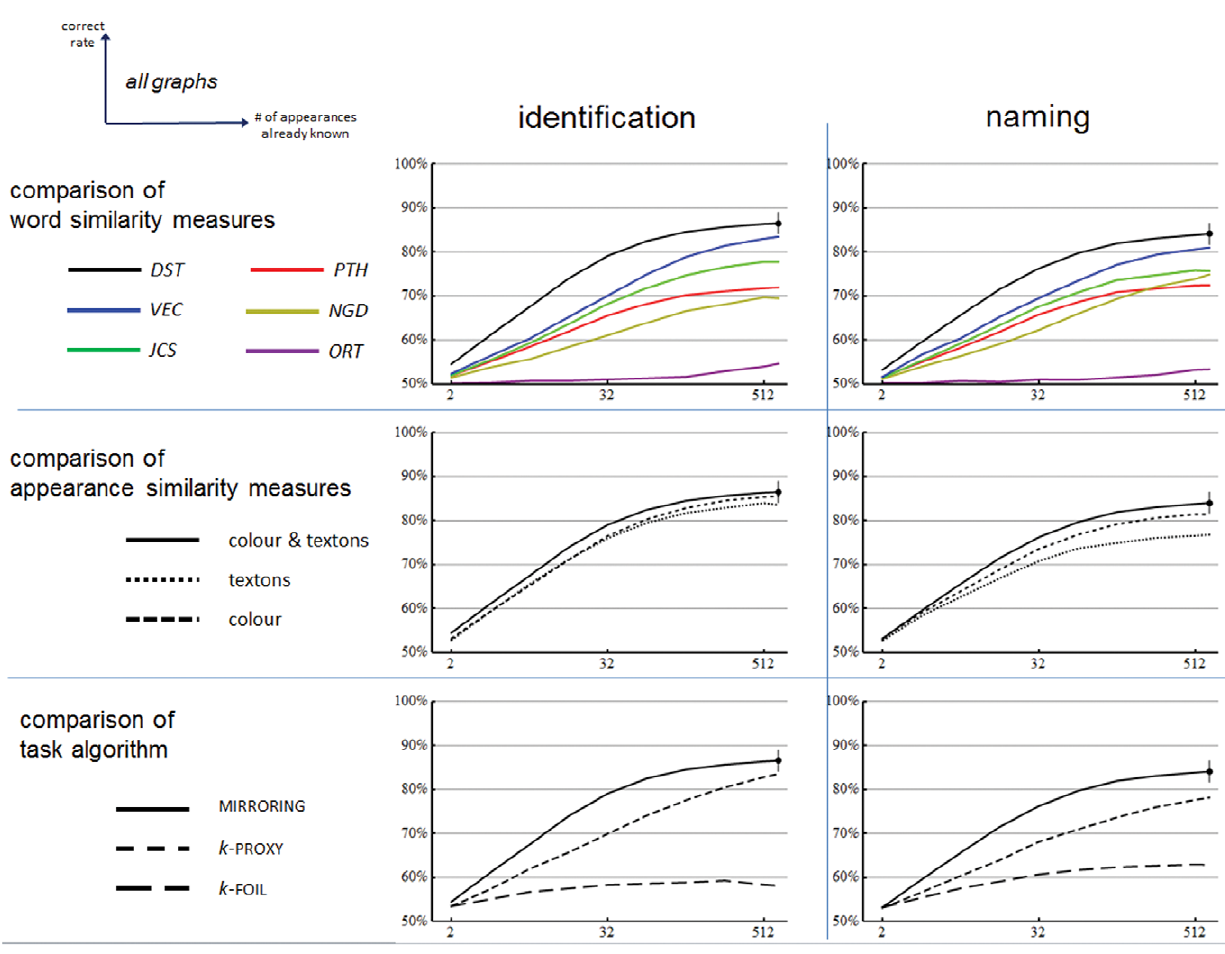
Figure 8. Effect of varying components of the computational system. Plots show correct rates versus number of known appearances for various combinations of word similarity, appearance similarity and trial algorithm. The unvaried components in each row are fixed at the best option. So, for example, the word similarity measure used for the middle row is DST . In all cases, baseline performance is 50%. Within each column, the solid black curve is the same in all plots, and the same as figure 6. At the highest point of these curves an error bar indicates the 95% confidence interval for the maximum performance obtained. Other confidence intervals are not shown but are no larger in magnitude.